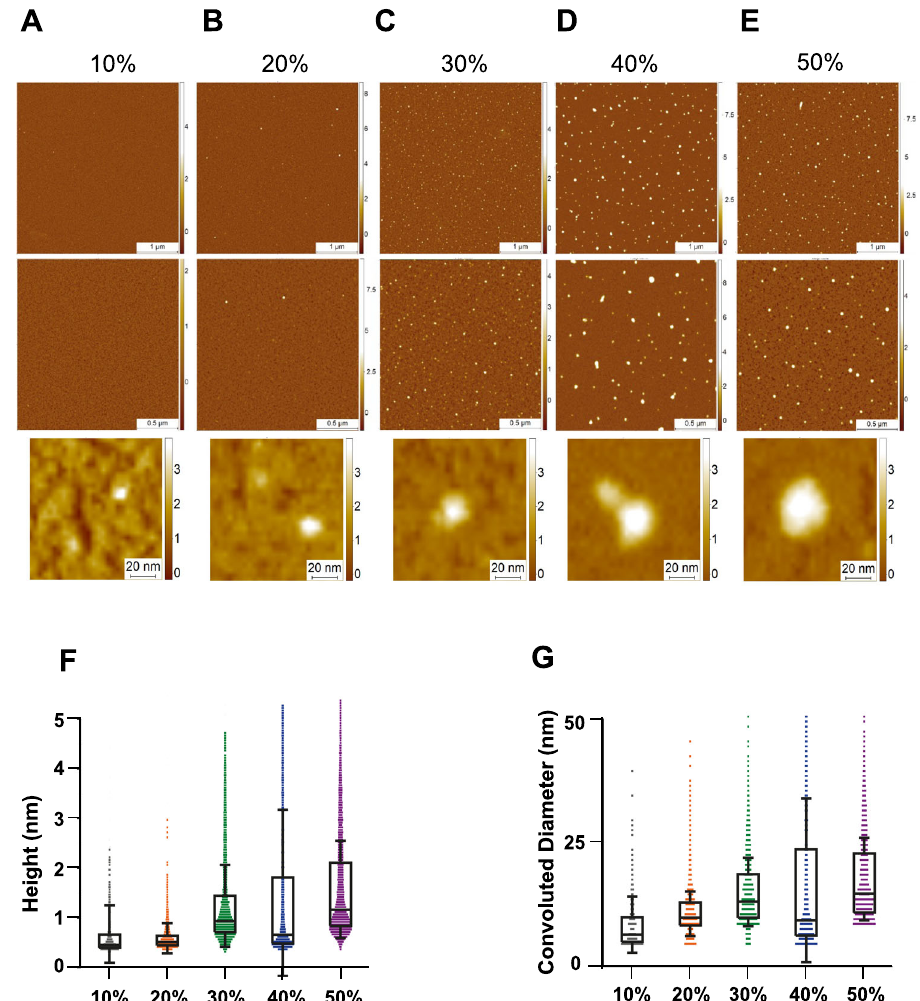
Fig. 4 |Characterizationof3D morphologyofdifferent sucrosefractionsusing high-resolution AFM imaging. A – E Representative AFM images of the sucrose fractionsincludingzoom-insnapshotsofindividualaggregates. F , G Boxplotofthe height ( N =527 for 10%, N =2785 for 20%, N =6884 for 30%, N =2473 for 40% and N =7333 for 50%) and convoluted diameter ( N =533 for 10%, N =2786 for 20%, N =6885 for 30%, N =2445 for 40% and N =6585 for 50%) ( G ) of each fraction. The